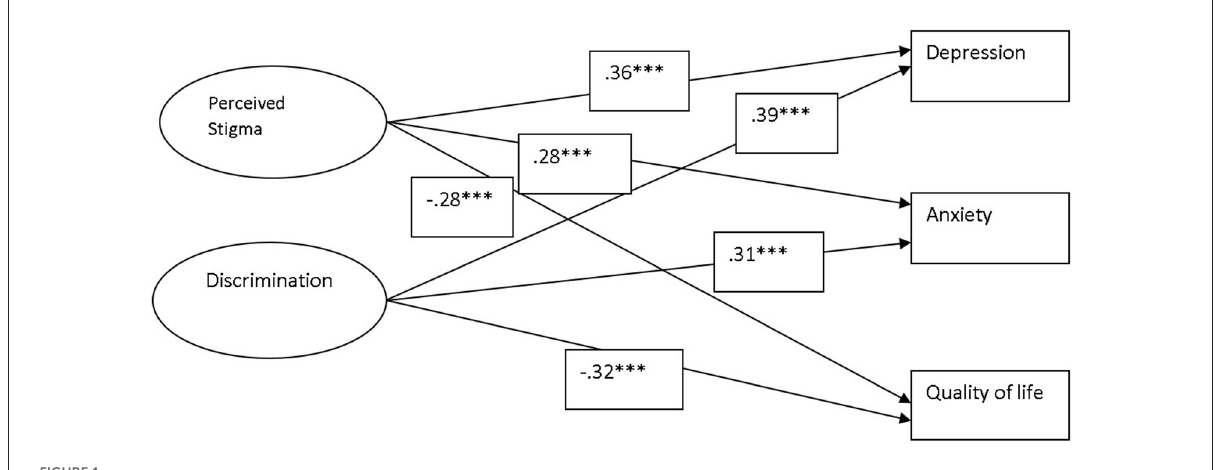
FIGURE1 Outcome model of study. *** p < 0.001.